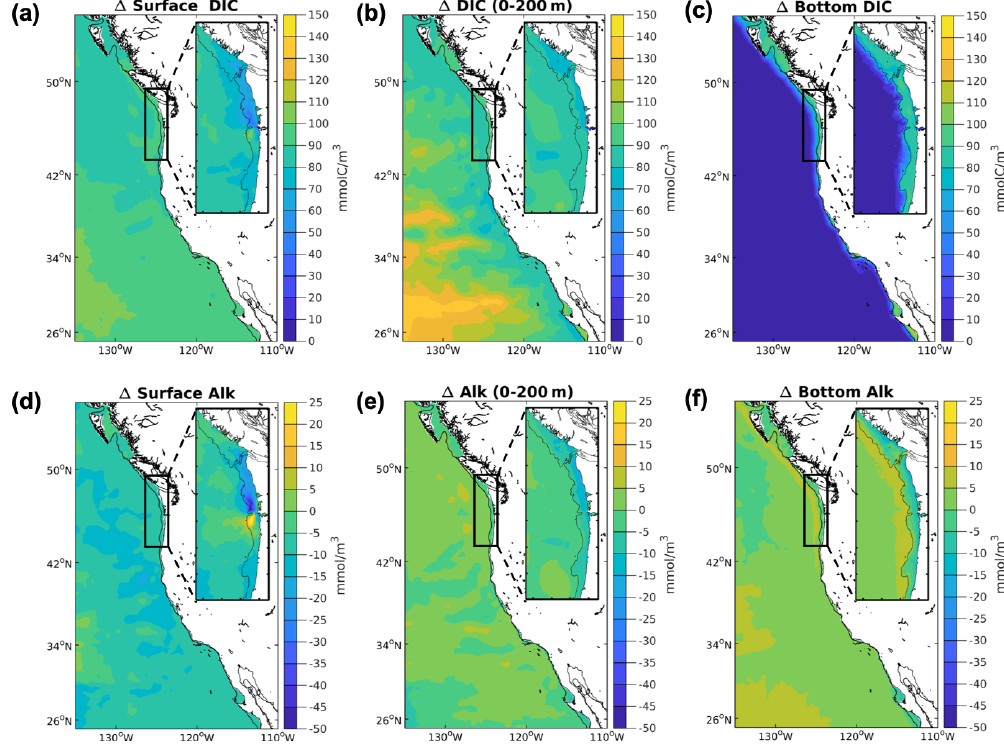
Figure 7. Projected changes for DIC and TA in the CCS. Simulated downscaled changes in annual average DIC and TA (mmolm − 3 ) in the future and the base/present conditions for the 12km (CCS-wide, full panel) and 1.5km (N-CCS, inset) projections. (a) Surface DIC (b) , 200m depth-averaged DIC, (c) bottom DIC, (d) surface TA, (e) 200m depth-averaged TA, and (f) bottom TA. Positive values indicate a change that is greater in the future than the base/present condition, and negative values indicate lower values in the future than the base/present